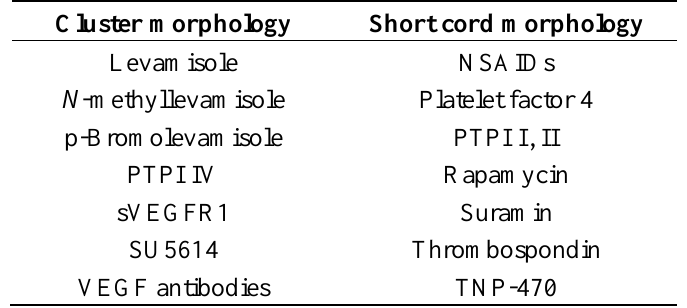
Table 2. Morphological effect of angiogenesis inhibitors in the coculture